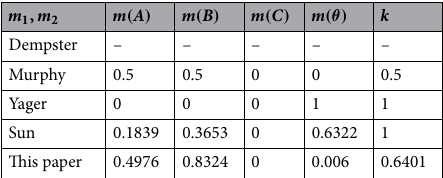
Table 4. The processing results of different algorithms to rule failure